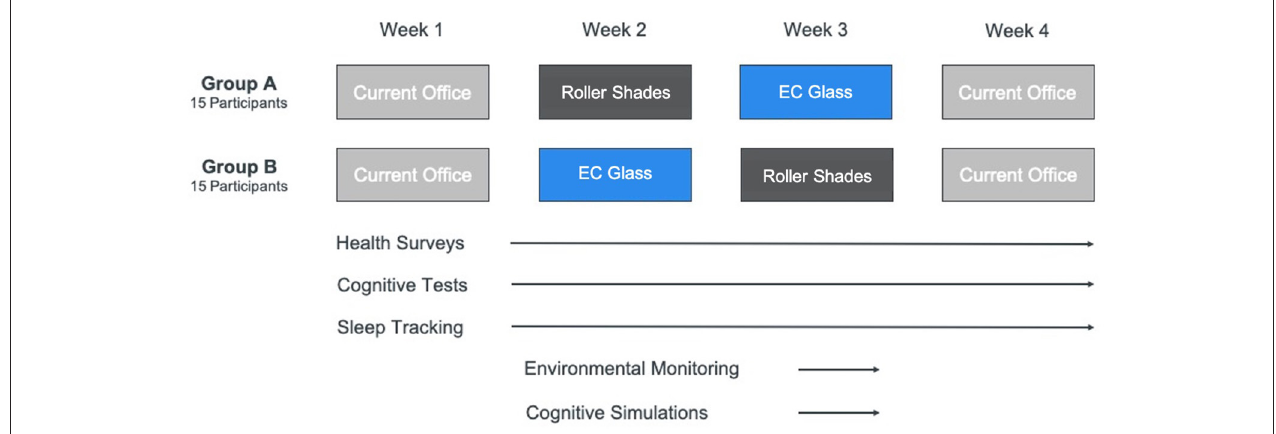
FIGURE 1 | Crossover study design over four weeks, including two onsite study conditions: Roller Shades and EC Glass. Participation requirements of surveys, cognitive testing, sleep tracking, and environmental monitoring are described below the figure and represent activities from the overarching study. The current paper focuses on the health surveys which included environmental perceptions, physical health symptoms, and mental health indicators.